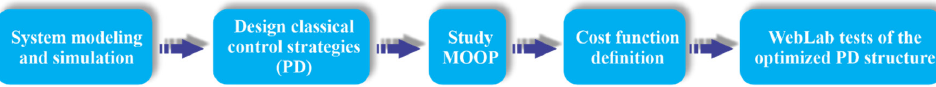
Figure 13. Experimental procedures to be developed by the students.